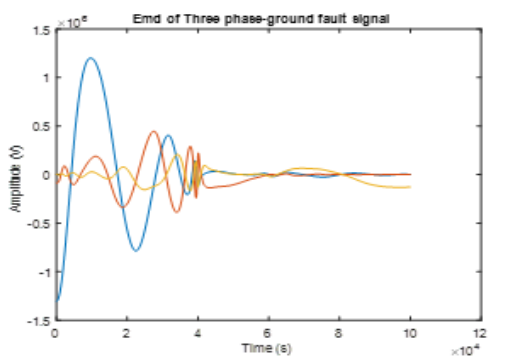
Figure 18. Waveforms of Three phase-ground signal Rather than wavelet, the EMD framework needs to mean greatest and least SD values [23]. Thus, the EMD is the suitable methodology for this part of the review (tables 1 to 2). Table 1. SD and Mean of EMD and DWT